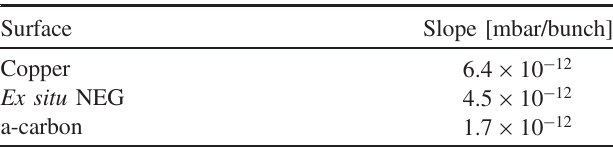
TABLE I. Slopes of the EC increase as a function of the number of bunches, for the three surfaces.